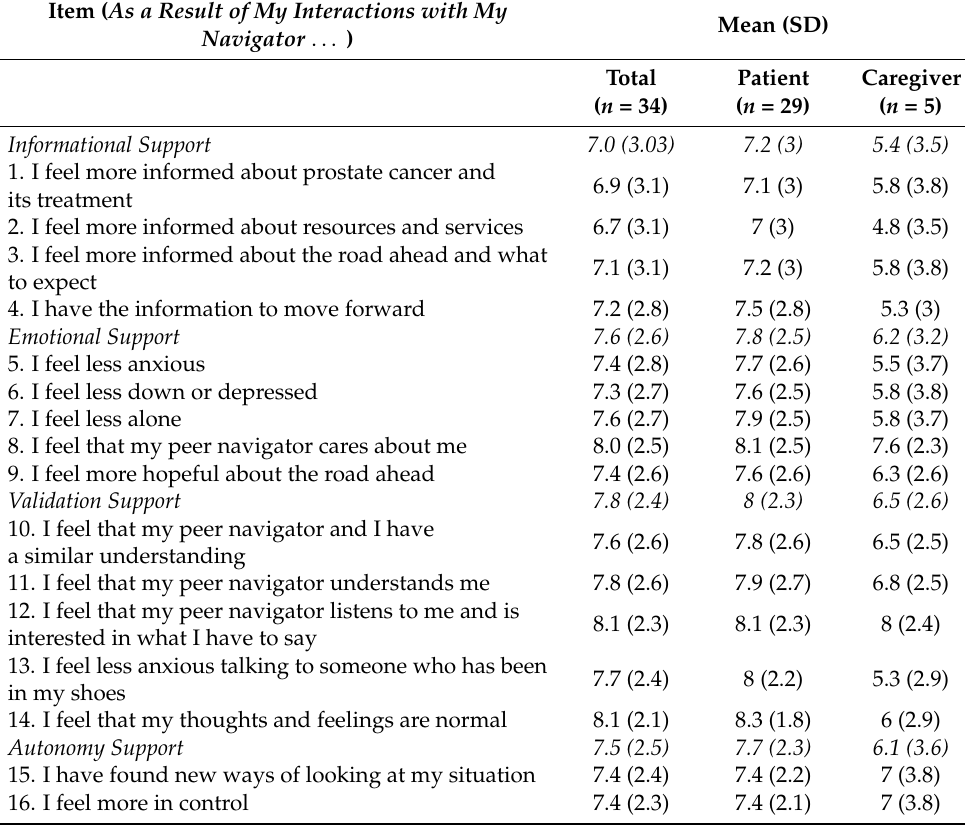
Table 4. Perceived benefits gained from interactions with